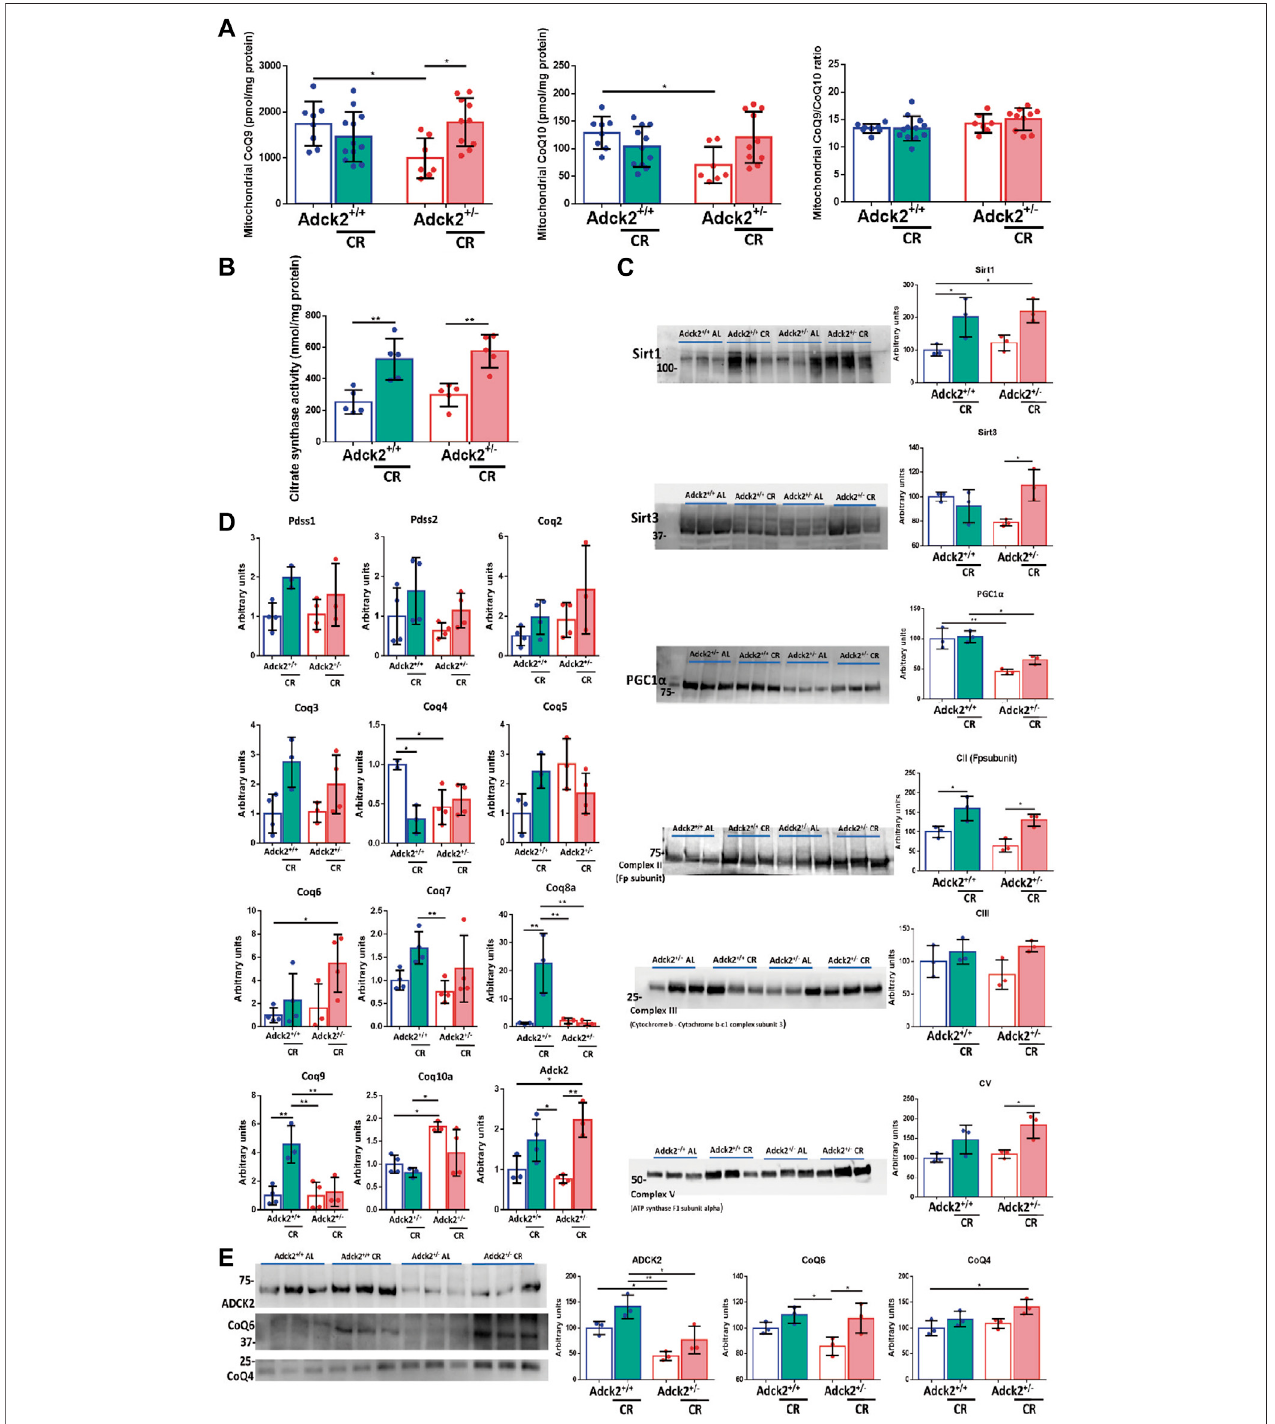
FIGURE8| CRmodulationoverCoQlevelsandmitochondrialbiogenesis. (A) .CoQ 9 andCoQ 10 levelsonmitochondriaisolatedfromskeletalmuscle.RatioCoQ 9 / CoQ 10 .Datarepresentsthemean±SD(Adck2 +/+ N=8,Adck2 +/ − N=7,Adck2 +/+ CRN=12,Adck2 +/ − CRN=10) (B) .Citratesynthaseactivityonskeletalmuscle.Data represents the mean ± SD N = 5 (C) . Protein levels of mitochondrial metabolic markers from skeletal muscle homogenate. Data represents the mean ± SD N = 3 (D) . Expression levels ofCoQ genesin skeletal muscle homogenate. CR,calorie restriction.Datarepresent the mean ± SD N= 3-4. (E) . Adck2 and Coq proteinslevels in mitochondrial isolated from skeletal muscle. CR, calorie restriction. Data represent the mean ± SD N = 3. One-way ANOVA test was applied. * p < 0.05; ** p < 0.01; *** p < 0.001; **** p < 0.0001.